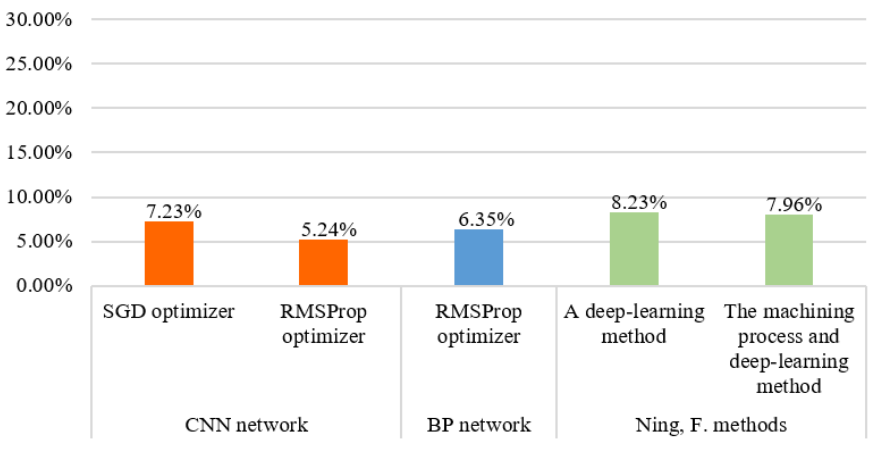
Figure 14. MAPEs for different methods. Figure 13. MAPEs for different